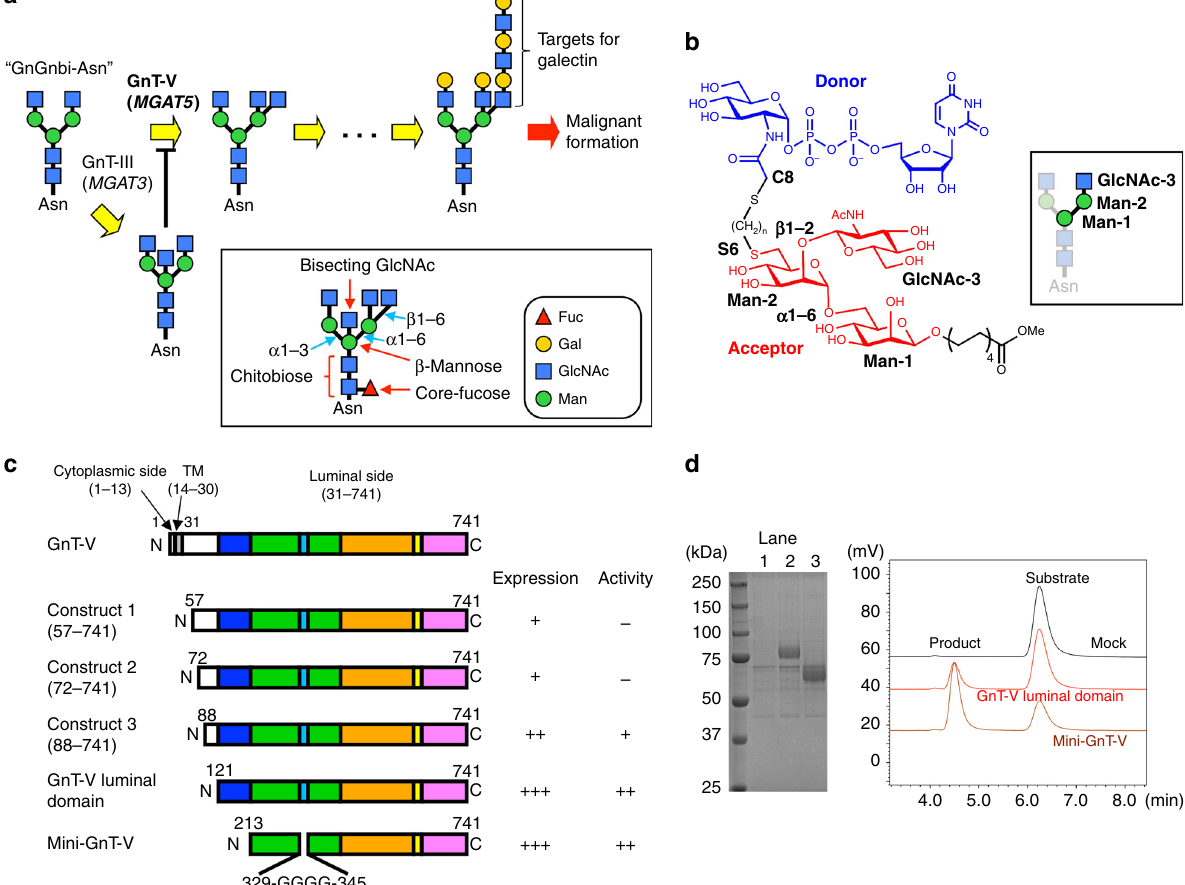
Fig. 1 GnT-V transfers β 1-6 branch on N -glycan via C-terminal region. a The β 1-6 branch formation of N -glycan catalyzed by GnT-V. The substrate of GnT-V is GlcNAc-terminated biantennary glycan termed “ GnGnbi-Asn ” . The β 1-6 branch formation leads to further LacNAc extension, which is the target for galectin. The β 1 – 4 branch at β -mannose catalyzed by GnT-III, named as bisecting GlcNAc, hampers β 1-6 branch formation. Monosaccharide symbols follow the symbol nomenclature for glycans (SNFG) system 79 . Nomenclature of sugar residues (red arrows) and glycosidic linkages (cyan arrows) are indicated in boxes. b Chemical structure of bisubstrate-type inhibitor of GnT-V used for co-crystallization. Donor and acceptor substrates are colored with blue and red, respectively. Three sugar residues (GlcNAc β 1-2Man α 1-6Man) of acceptor moiety are labeled. In this study, the inhibitor of which the linker length is ( n = 3) and K i value is 18 μ M 25 was used. Acceptor trisaccharide corresponds to α 1-6 branch of biantennary glycan (GnGnbi) as shown in the